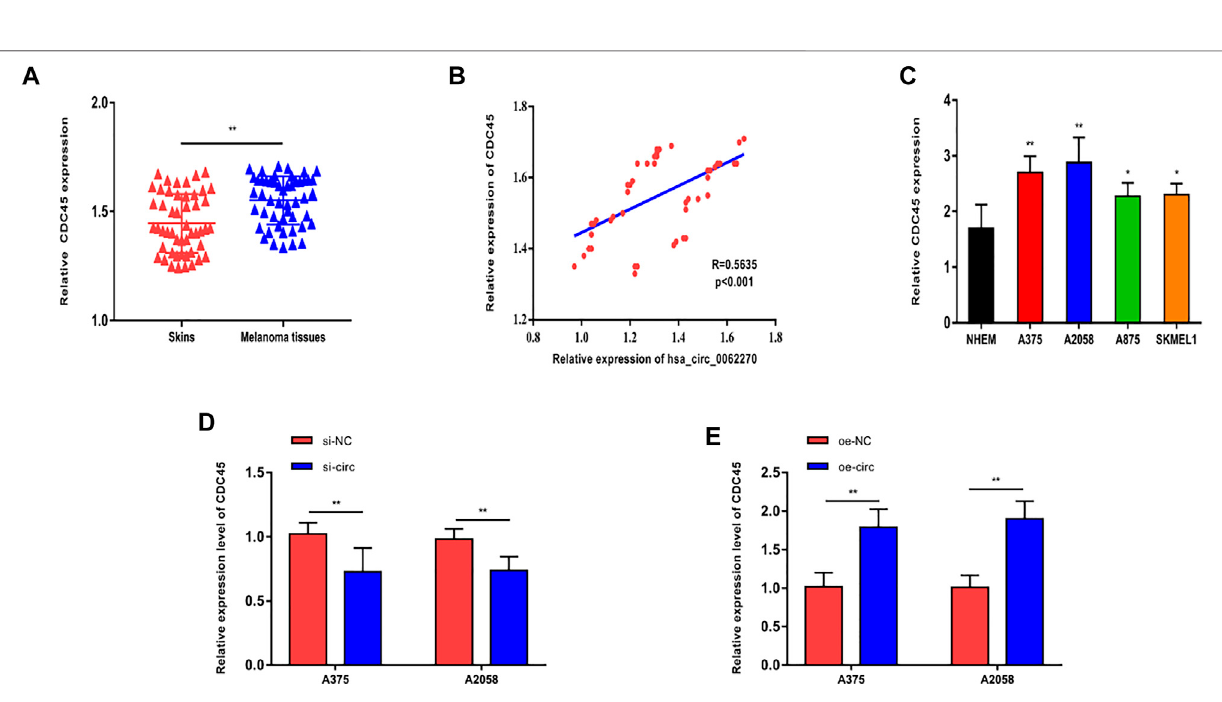
Frontiers in Genetics |